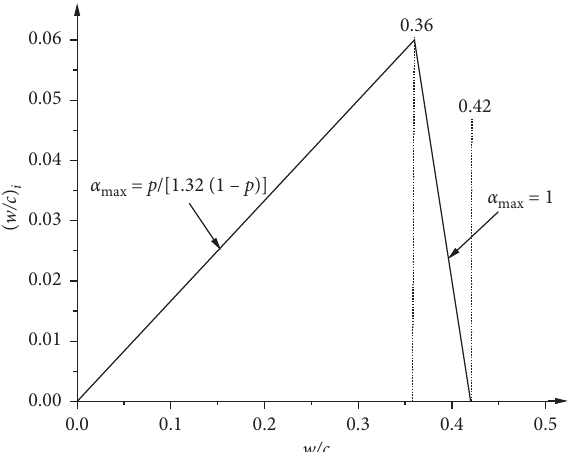
Figure 1: Minimum amount of IC water needed to obtain α cement pastes without mineral